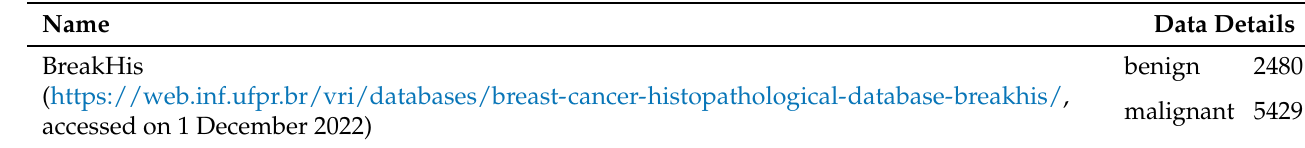
Table 1. Common breast cancer pathological image public